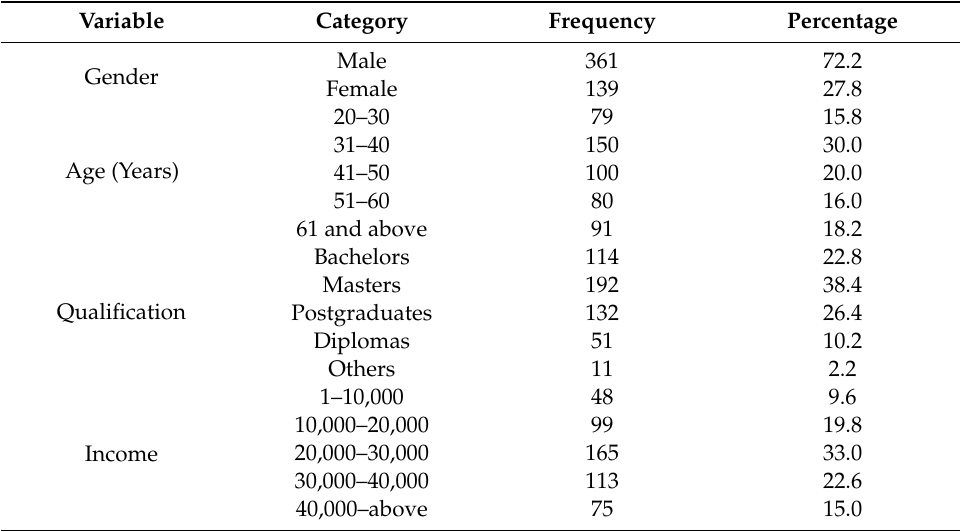
Table 1. Demographic Analysis.